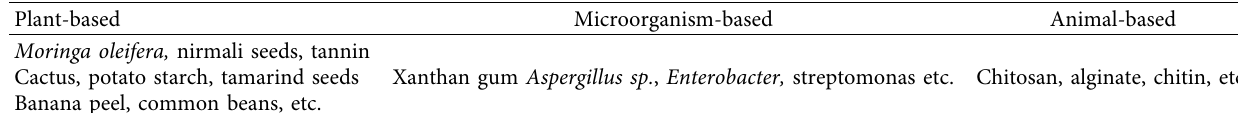
Table 1: Types based on various categories